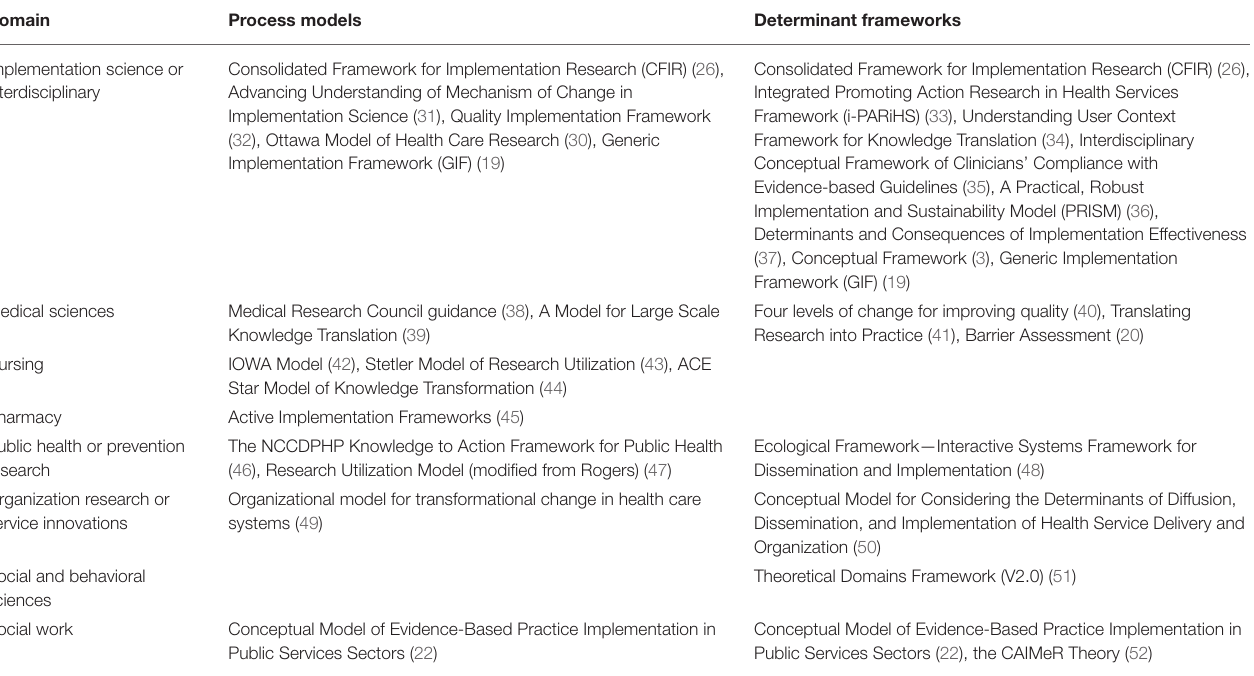
TABLE 3 | Overview of process models and determinant frameworks per